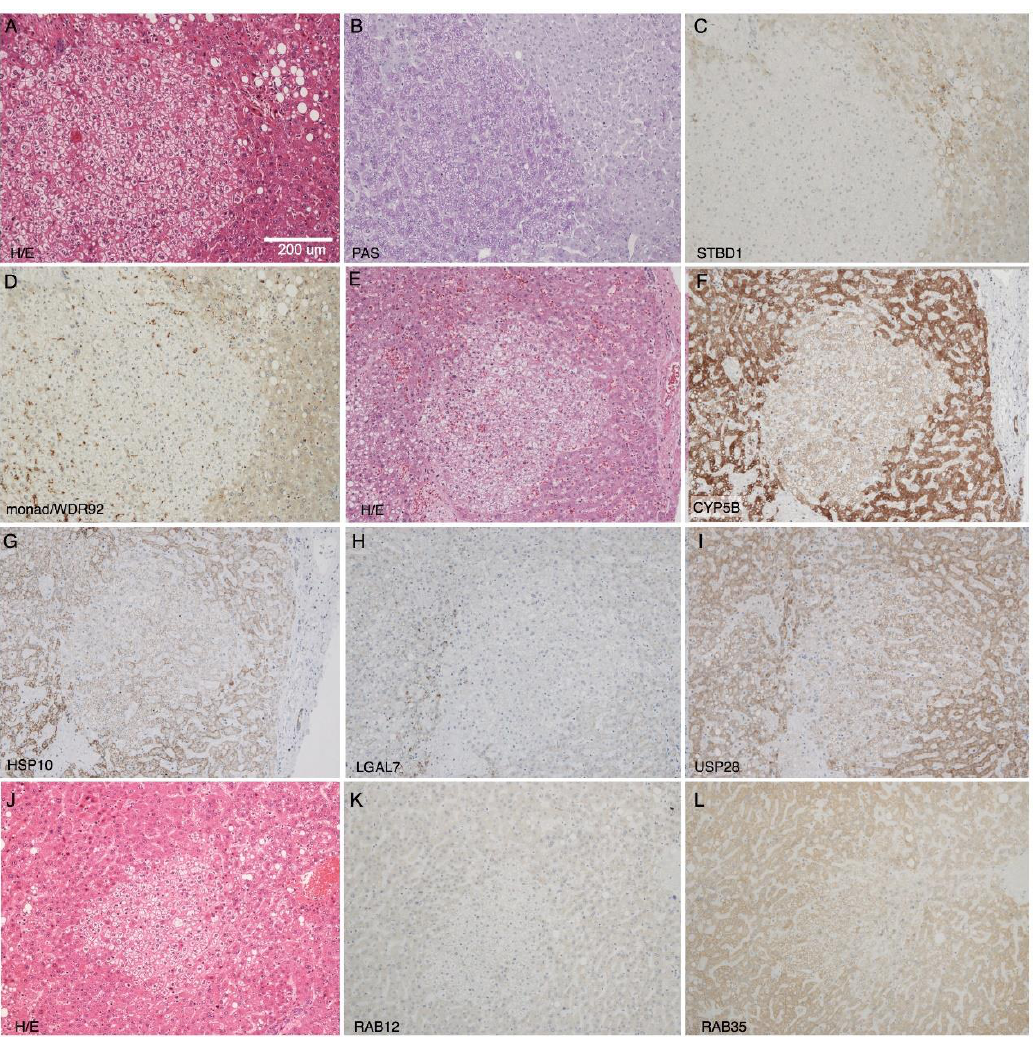
Figure 3. Histochemistry and immunohistochemistry of representative human liver specimens with CCF and neighboring tissue. Hematoxylin/Eosin (H/E) staining ( A , E , J ), PAS (Periodic acid-Schiff) reaction ( B ), and immunohistochemical detection of STBD1 ( C ), monad/WDR92 ( D ), CYP5B ( F ), HSP10 ( G ), LGAL7 ( H ), USP28 ( I ), RAB12 ( K ), and RAB35 ( L ). The scale bar in ( A ) is applicable to all panels ( B – L ).